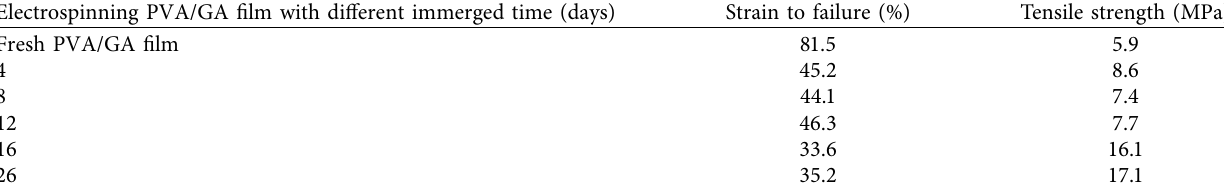
Table 4: Mechanical property test